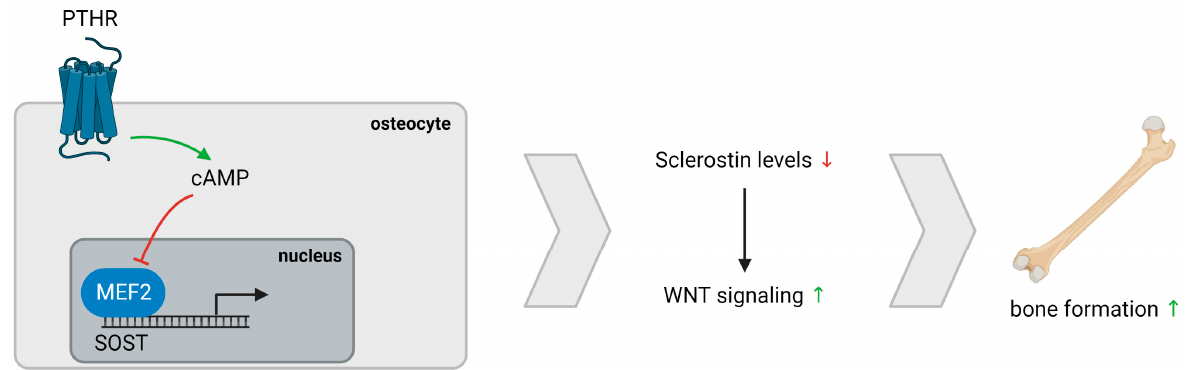
Figure 4. PTH/Sclerostin interaction. PTH exerts a direct effect on cAMP signaling, resulting in reduced SOST mRNA expression due to impairment of the MEF2-stimulated SOST promotor. Lower sclerostin levels cause increased WNT signaling and, eventually, bone formation. Abbreviation: PTHR, parathyroid hormone receptor.